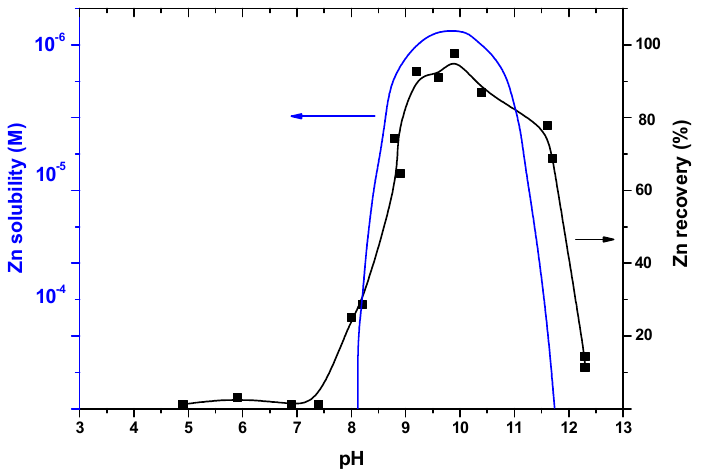
Figure 1. Precipitate (dispersed-air) flotation for the removal of zinc. Effect of solution pH using the following initial concentrations: zinc 1 × 10 − 4 M and dodecylamine (laurylamine) 2 × 10 − 4 M. The dotted line is a theoretical curve, showing the precipitation of zinc. Redrawn from Nova Sci. (Zouboulis and Matis,